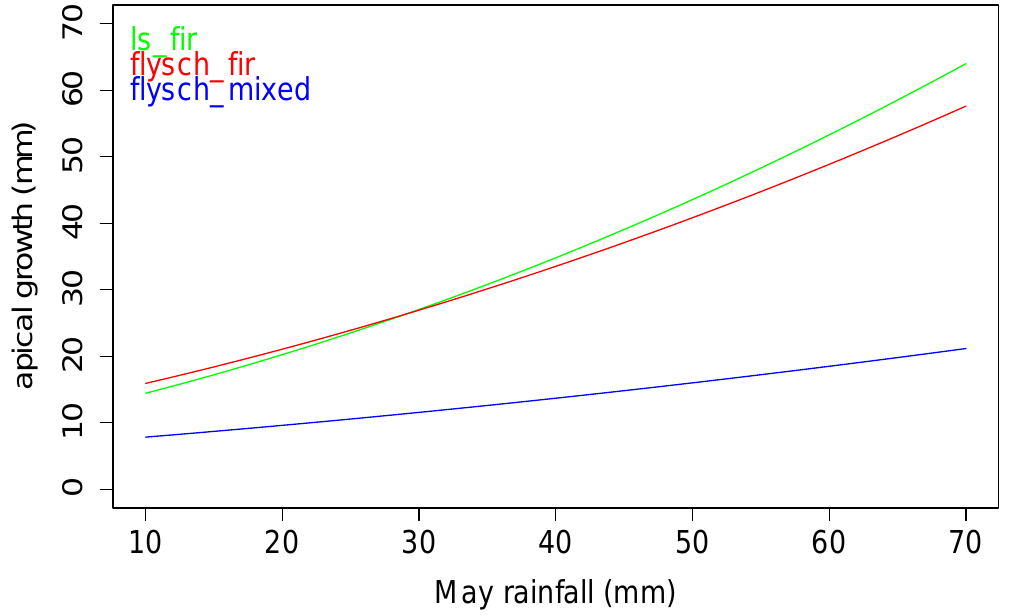
Figure 2. Idealised contribution to apical growth of May rainfall per site type. The curve parameters were estimated by lmm for each site type and reflect the contribution of the model segment depicting the e ff ect of May rainfall by site interaction. The contribution of the rest of the explanatory variables of the model, not depicted in this figure, has to be taken into account for the prediction of actual growth